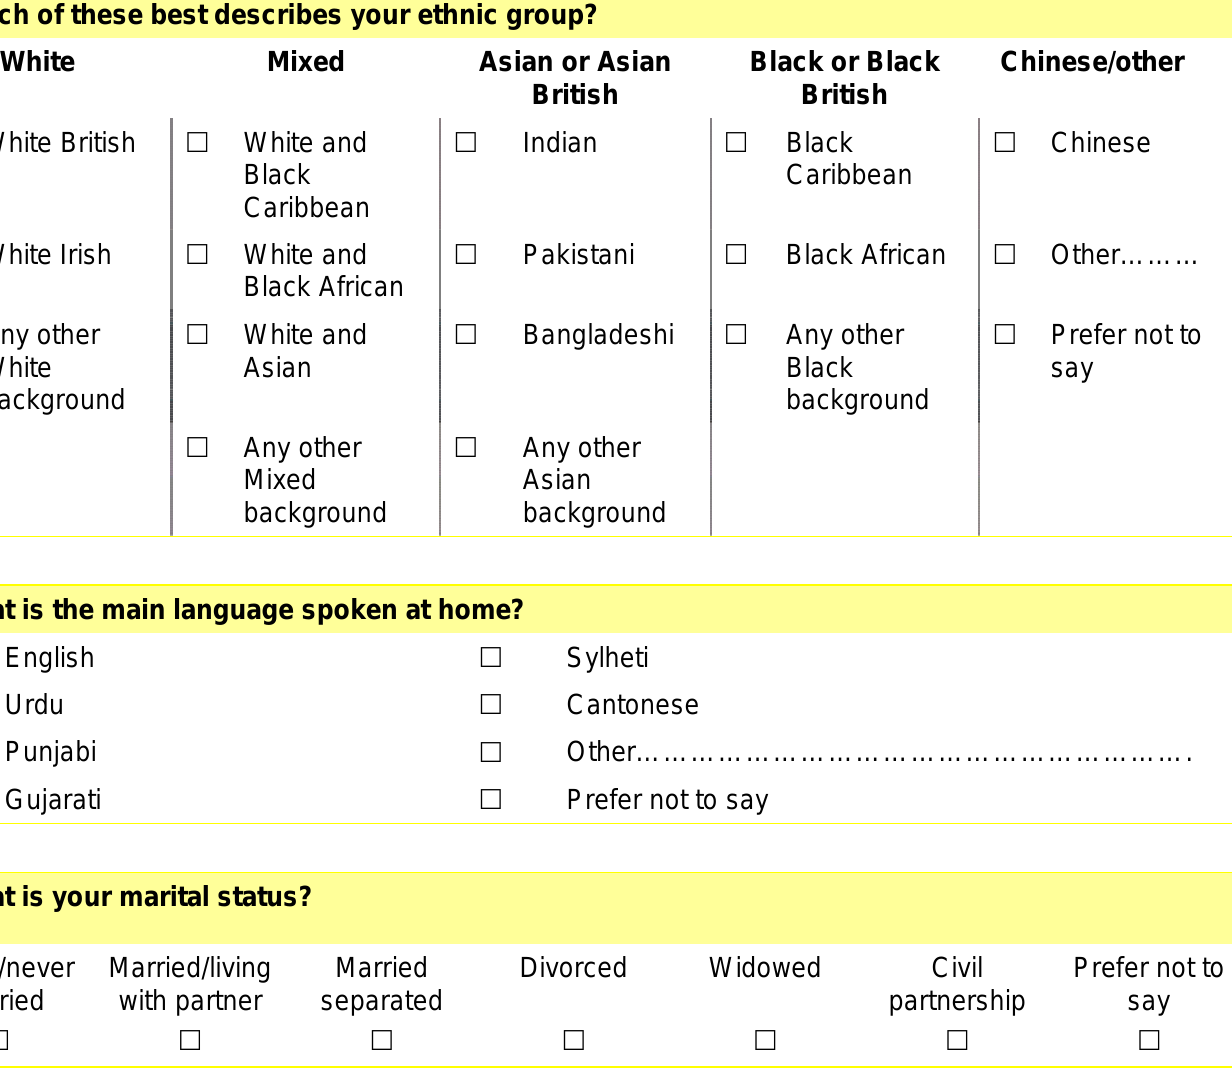
Cervical Cancer Awareness Measure Toolkit Version 2.1 Updated